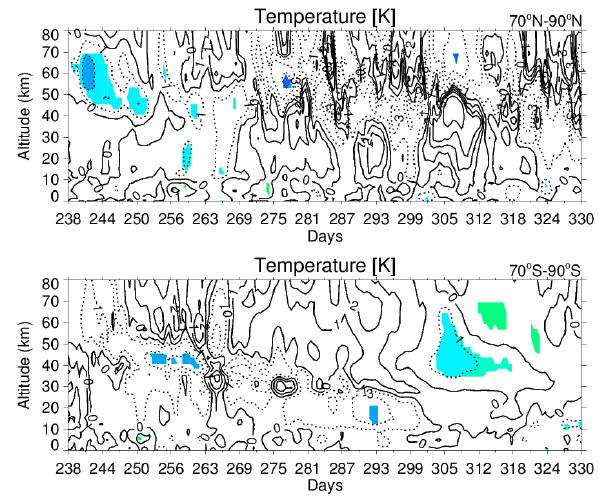
Fig. 5: Upper panel : Evolution of changes in zonal mean temperature profile for the polar region 452 (70°-90°N) in Kelvin. Lower panel : Same for 70°-90°S. Colors indicate areas with at least 95 % 453 Fig. 5. Upper panel: evolution of changes in zonal mean tempera- statistical significance. Contour levels: -10, -6, -3, -1, 0, 1, 2, 3, 5, 10 K. 454 ture profile for the polar region (70–90 ◦ N) in Kelvin. Lower panel: same for 70–90 ◦ S. Colors indicate areas with at least 95% statis- tical significance. Contour levels: − 10, − 6, − 3, − 1, 0, 1, 2, 3, 5, 10K.